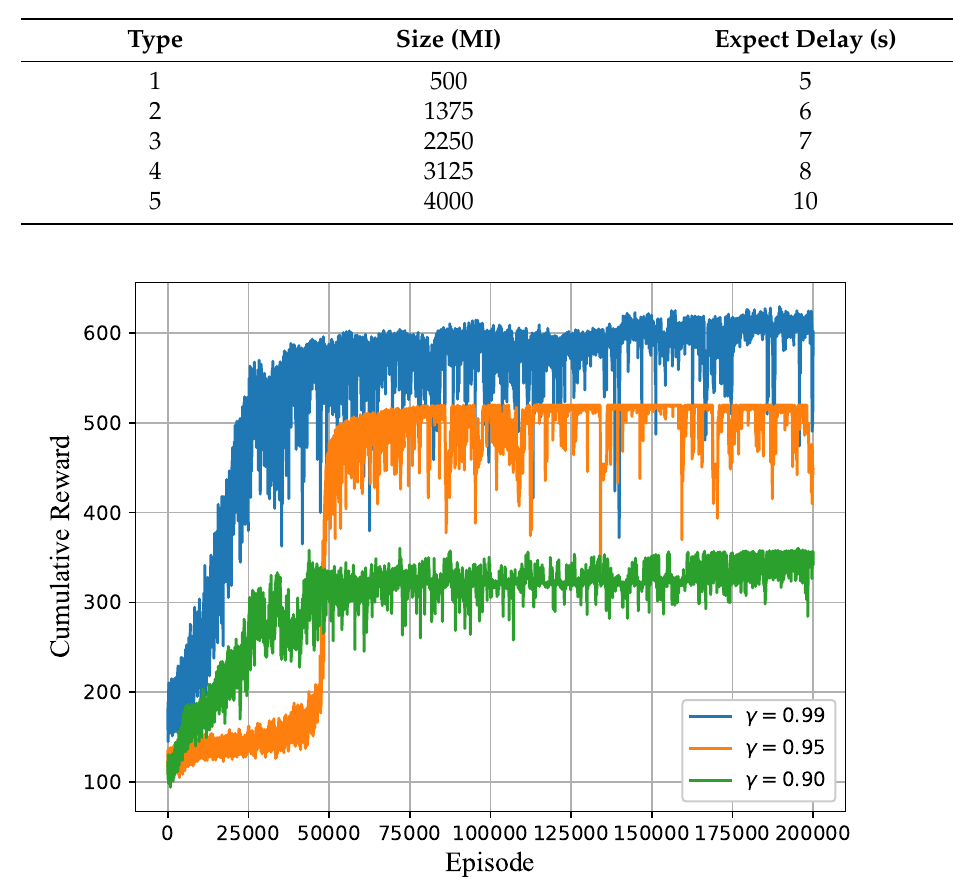
Table 2. Task characteristics. MI, million instructions.